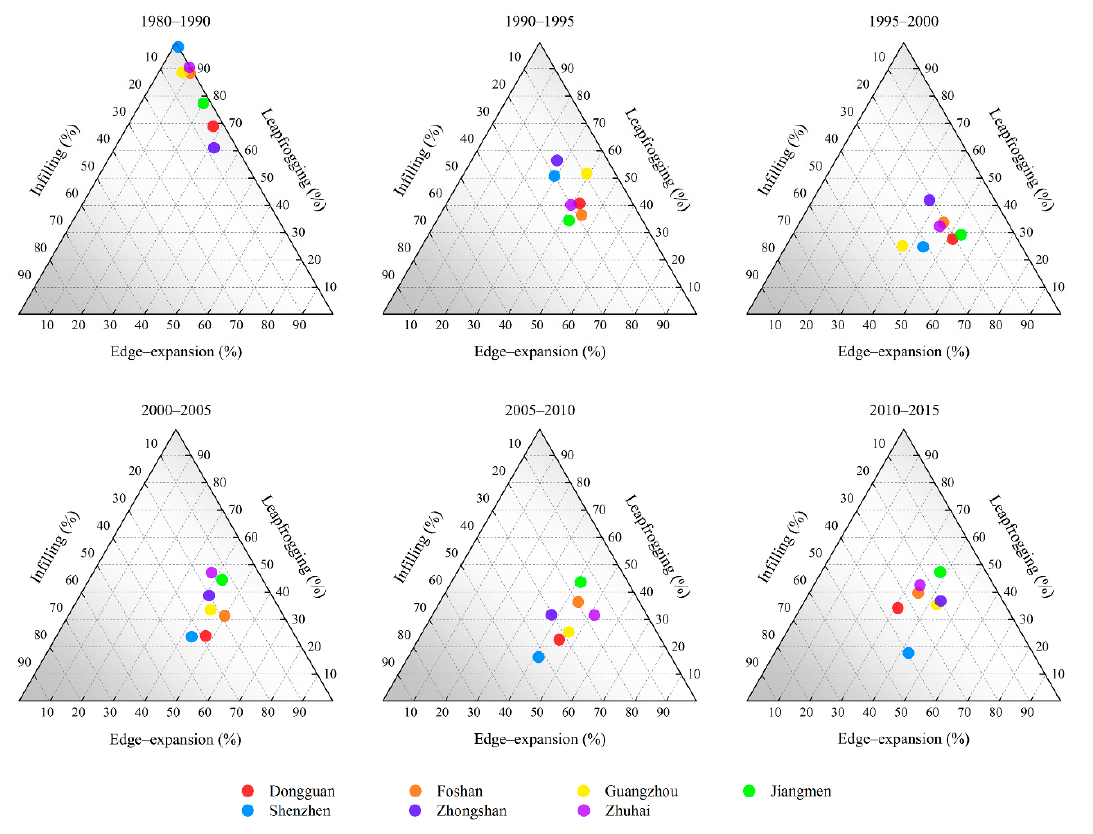
Figure 4. The temporal evolution of proportional composition of three urban growth types (edge–expansion, infilling, and leapfrogging), calculated from their number of patches in seven cities during 1980–2015.